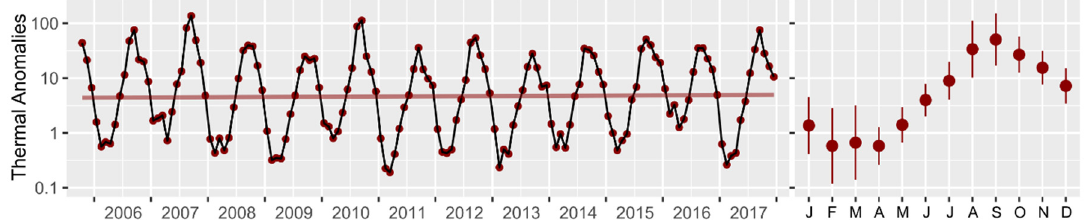
Figure 6. Temporal variation in average monthly values of thermal anomalies for the region.